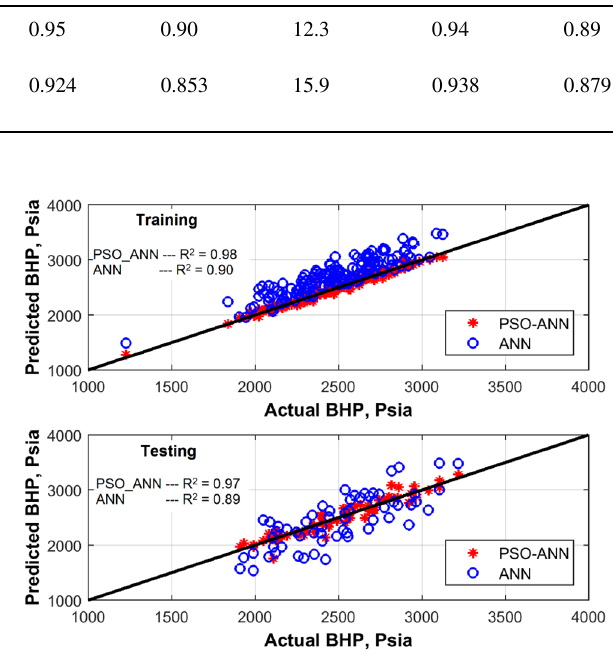
Fig. 6 Training and testing cross-plot of FBHP prediction using PSO- ANN and ANN